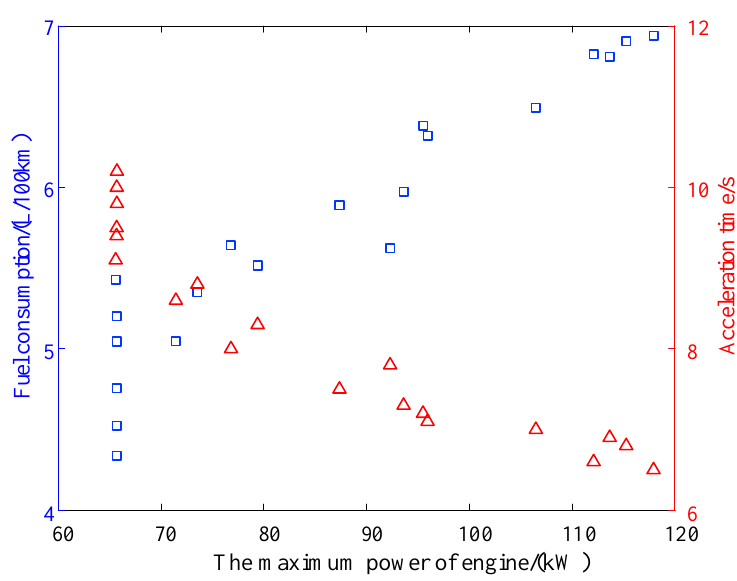
Figure 13. Effects of the engine’s maximum power on the fuel consumption and acceleration time. Figure 13. E ff ects of the engine’s maximum power on the fuel consumption and acceleration